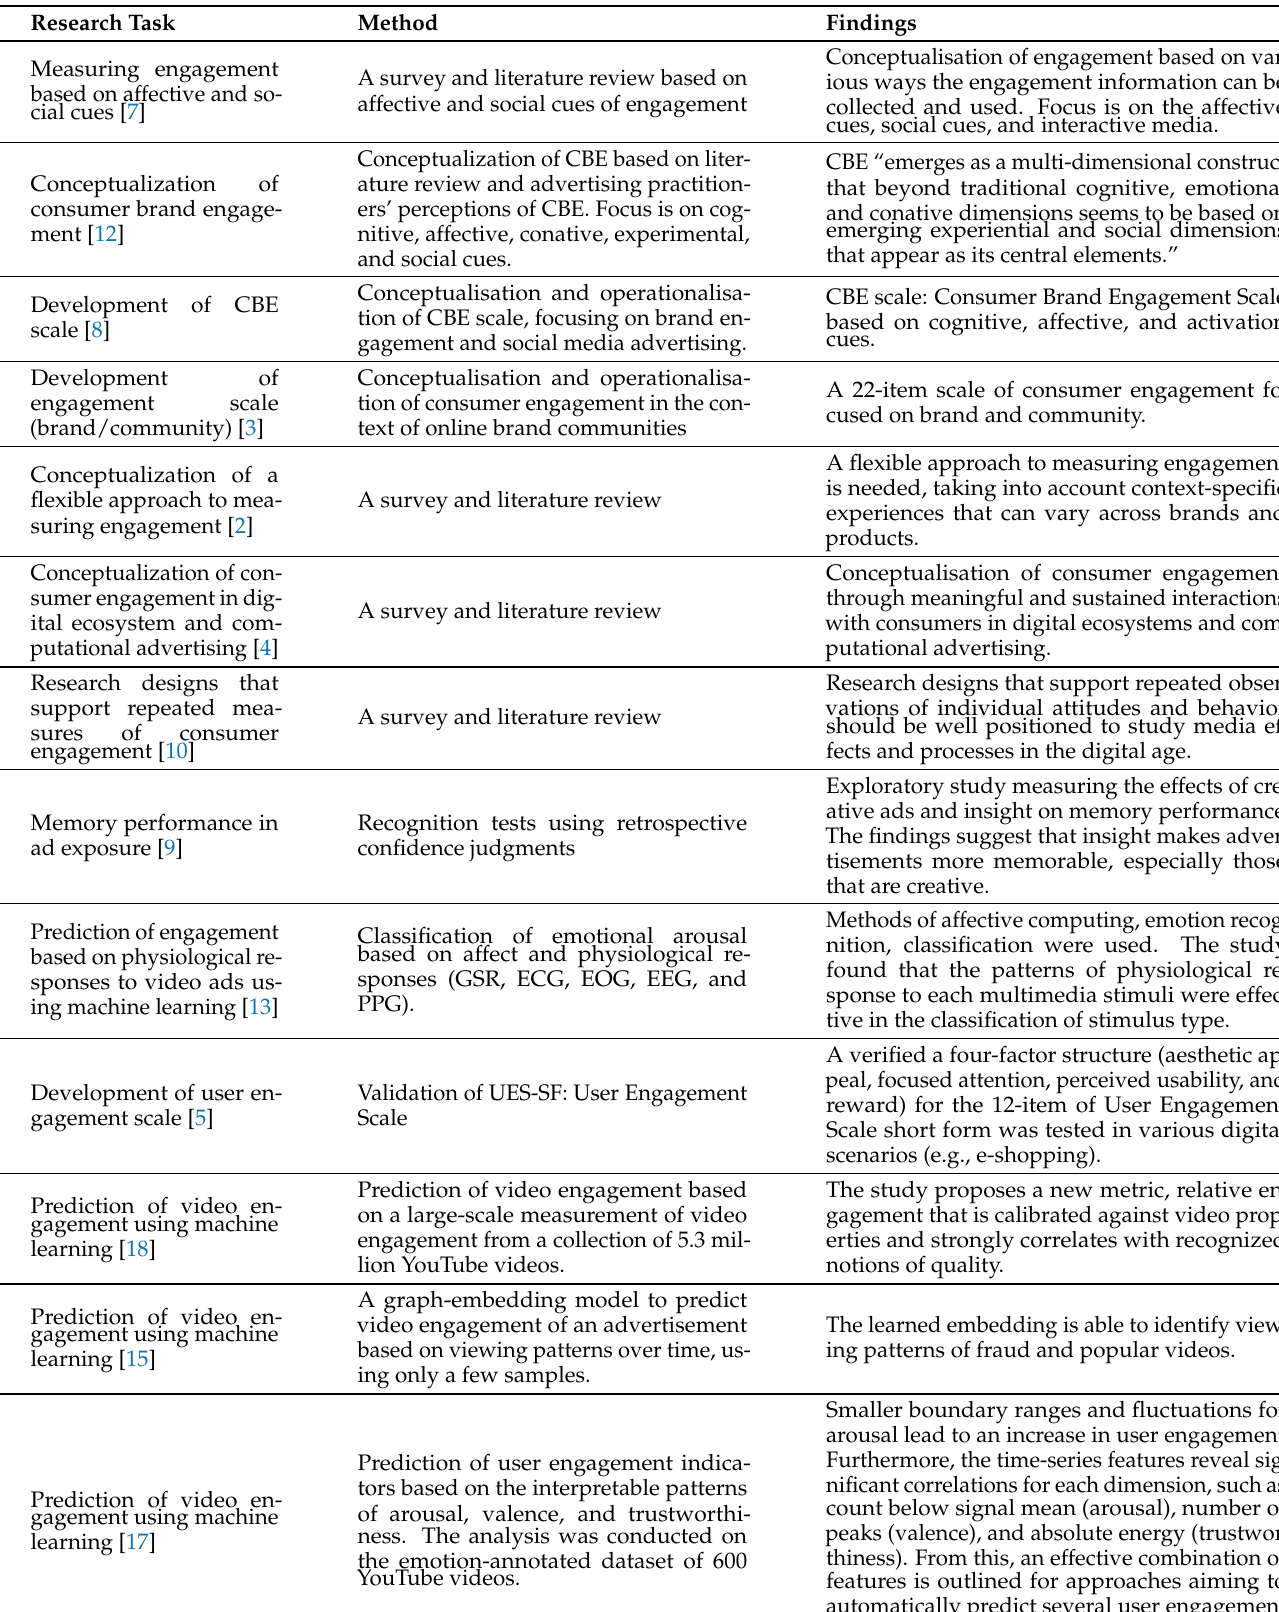
Table 1. Contributions of related work on consumer